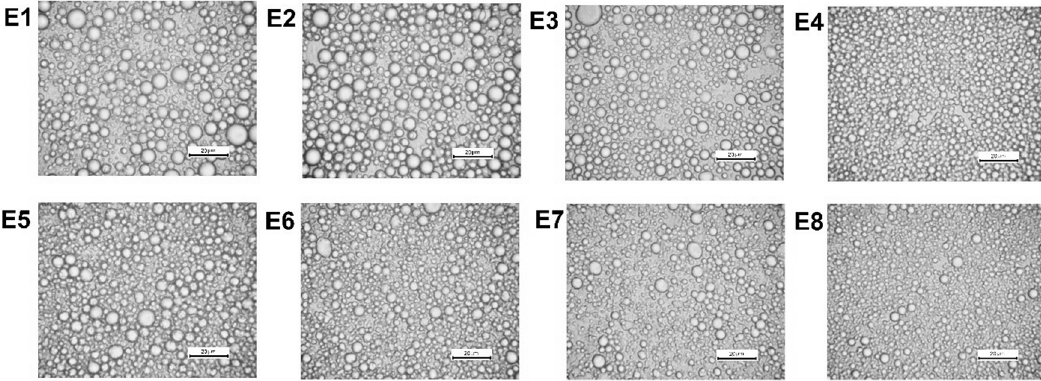
Figure 6. Microphotographs of the freshly prepared emulsions (G× 400)